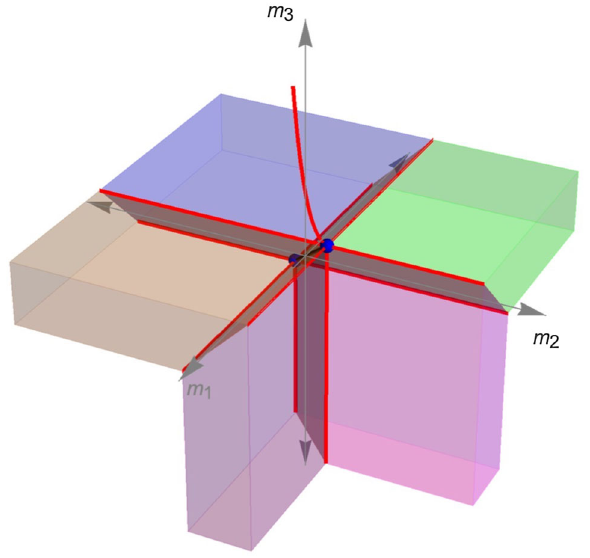
Fig. 11 The three-dimensional phase diagram of SU ( N ) k + p ψ 1 + q ψ 2 + ( F − p − q )ψ 3 with ( p + q ) − F / 2 ≤ k < F / 2 − p . ¯ σ c region in purple and ¯ σ c is represented by the light brown 3